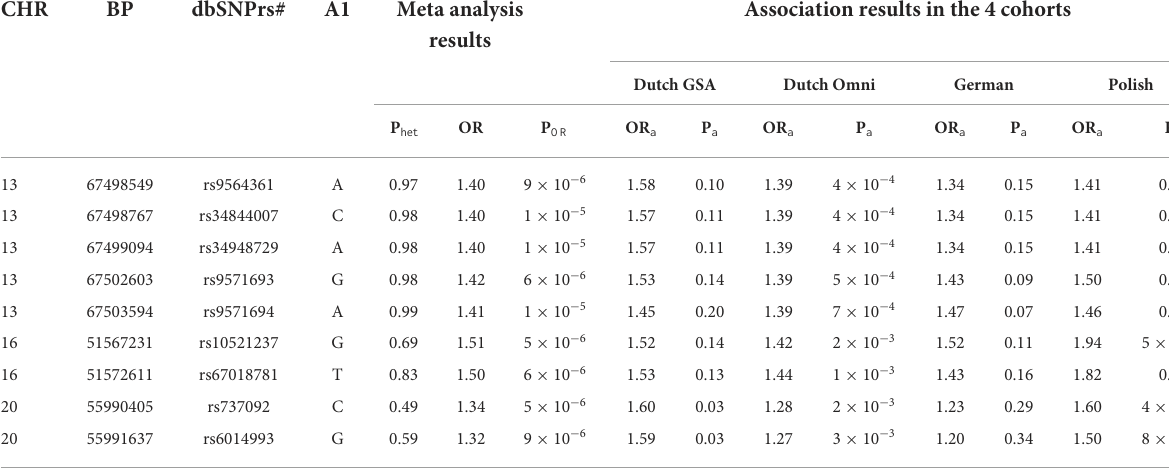
TABLE 1 Association results with PUV for the variants in loci with multiple variants residing within < 10kB of each other showing suggestive significance ( P < 1 × 10 − 5 ) and with the same effect direction in all 4 cohorts. CHR BP dbSNPrs# A1 Meta analysis Association results in the 4 cohorts results Dutch GSA Dutch Omni German